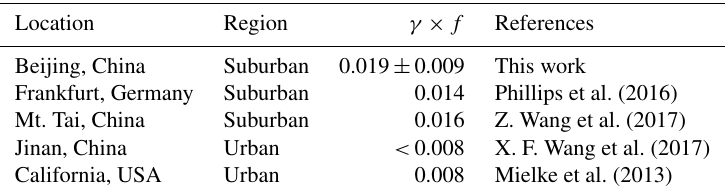
Table 3. Summary of the average γ × f values derived in the field